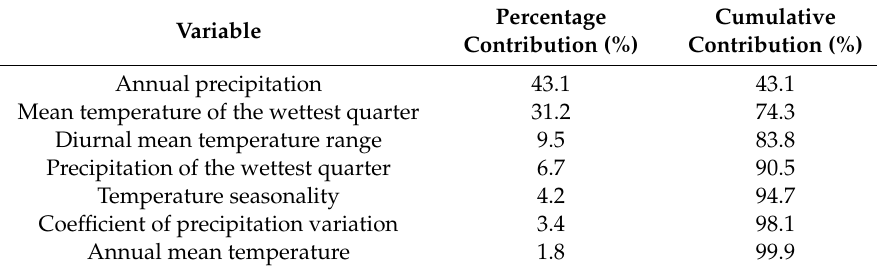
Table 2. Contribution of bioclimatic factors that affect maize cultivation in Kenya.